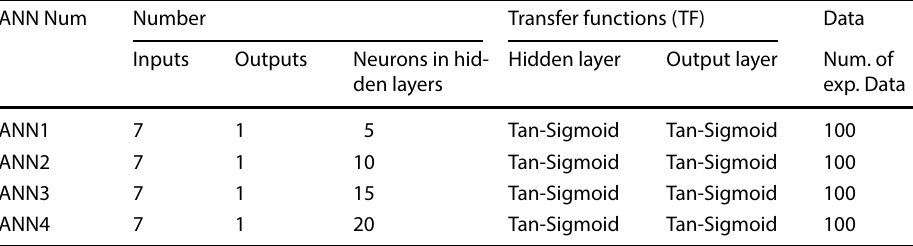
Table 5 The specific characteristics of different ANN models